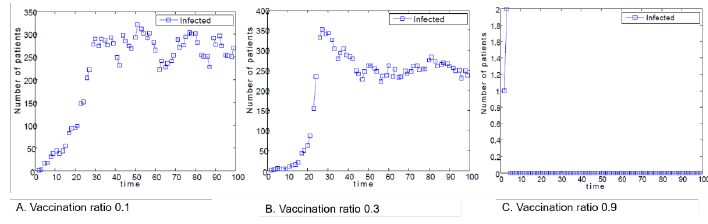
Fig. 2 Comparison of communicators (the penetration rate of mental health education is 0.1, 0.3, 0.9,